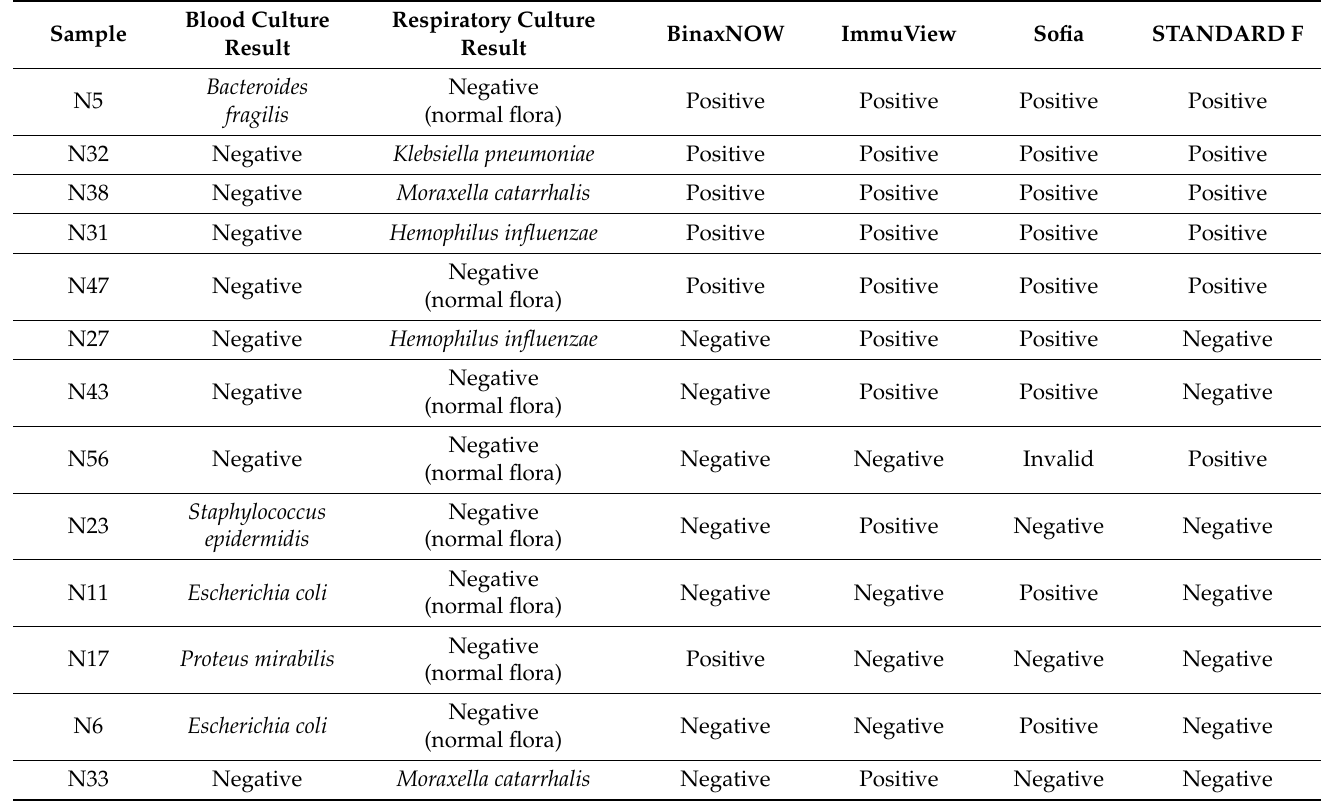
Table 5. False positive and discordant test results by four Streptococcus pneumoniae urine antigen tests in 13 patients without pneumococcal infection.